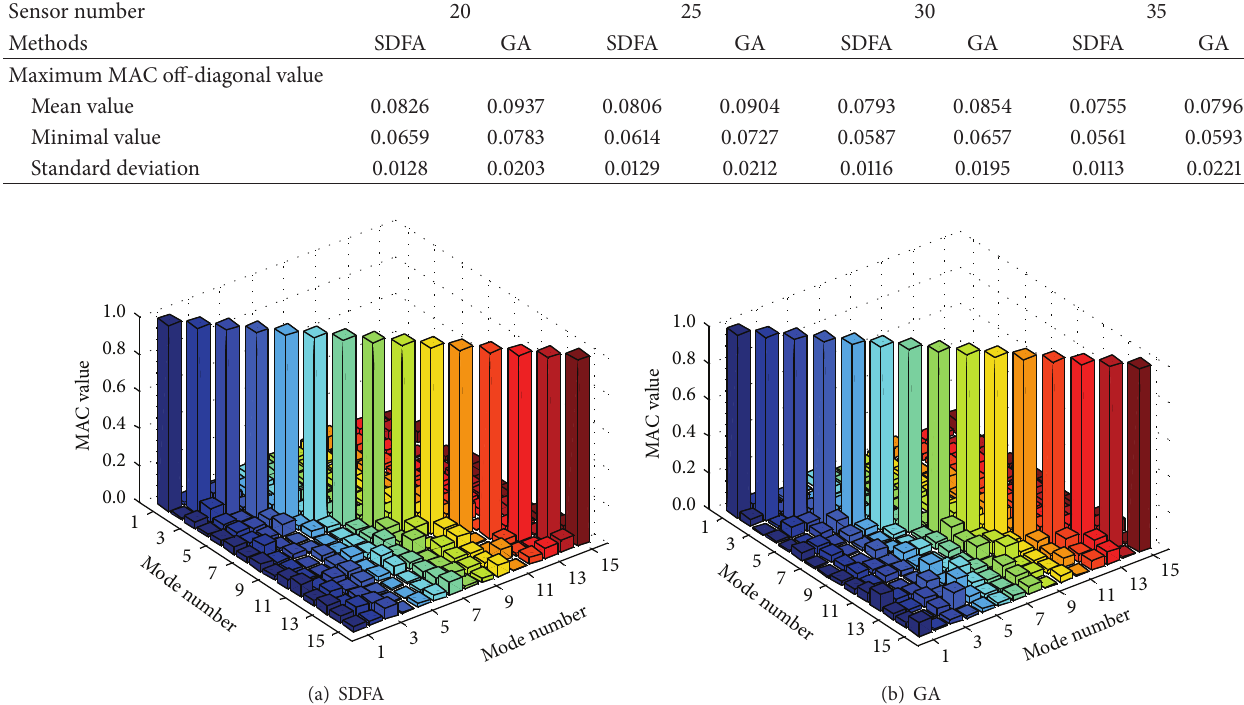
Figure 6: MAC values obtained from the optimal sensor configuration.